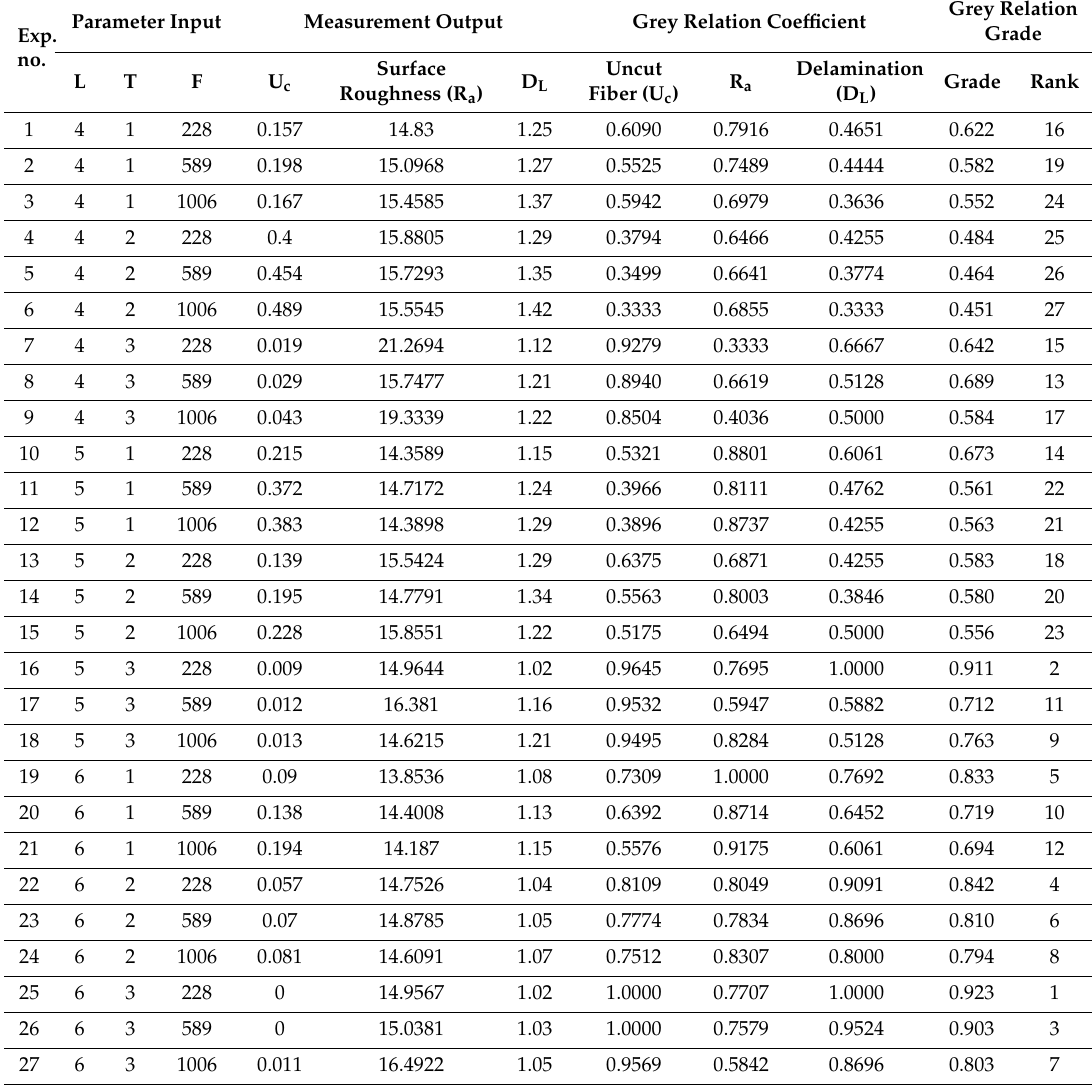
Table 4. Experiment measurement and grey relational analysis (GRA)